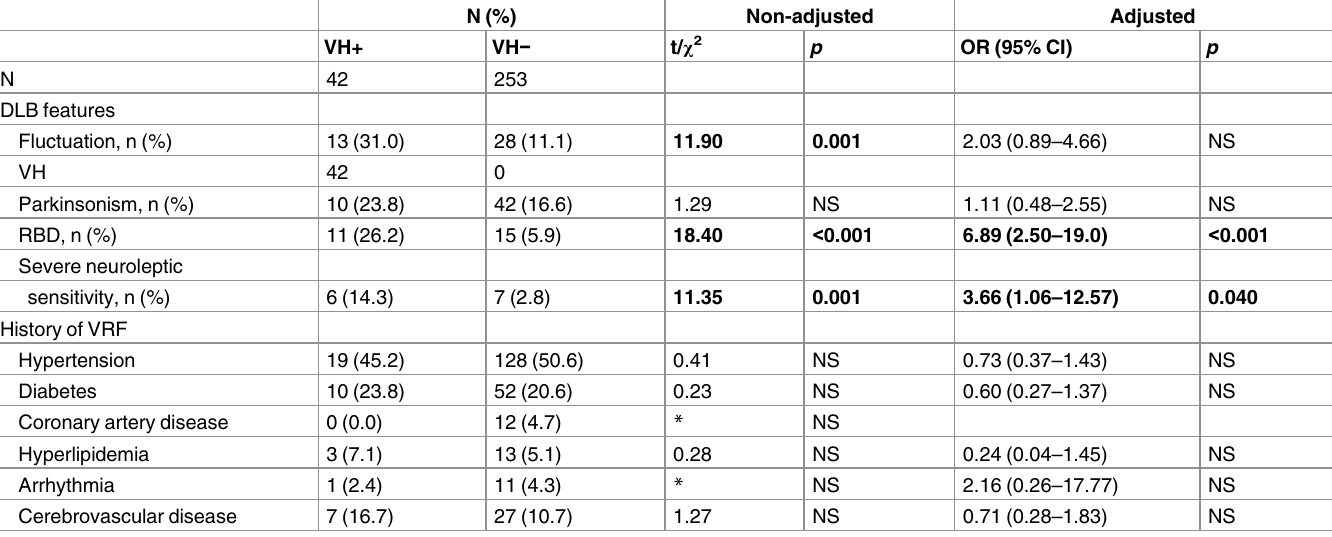
Table 2. Clinical manifestation of patients with Alzheimer’s disease presenting with or without visual hallucinations (VHs). N